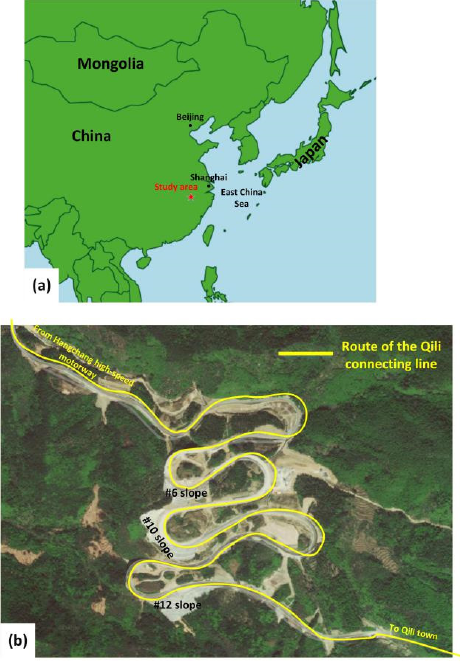
Figure 1. Location of the study area ( a ) and the route of the construction project ( b ).